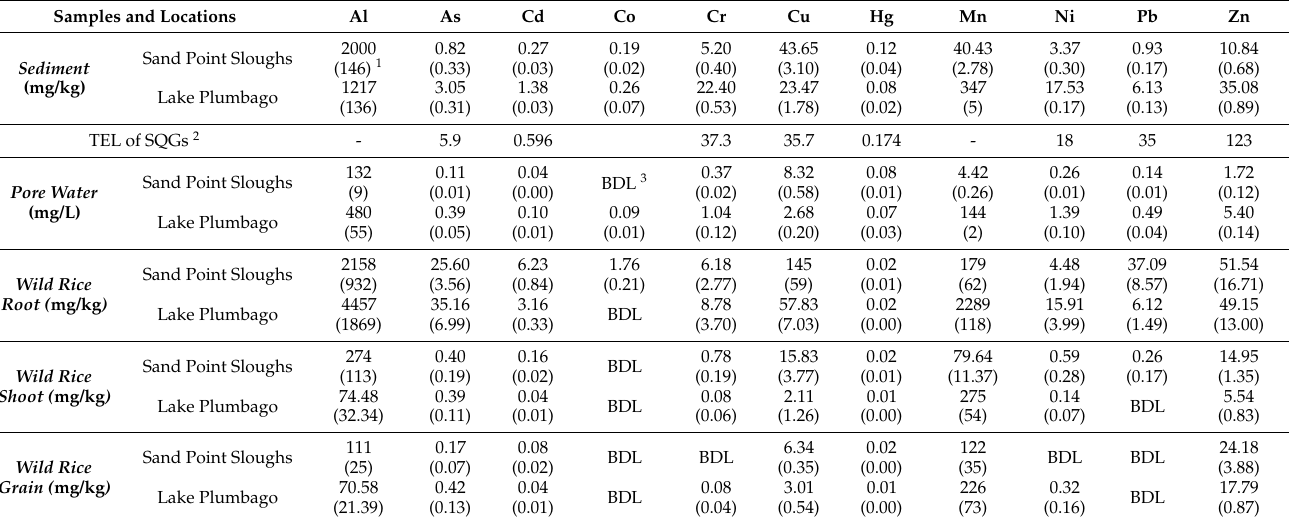
Table 1. Total toxic elements concentrations of sediment, water, porewater, and wild rice samples from Sand Point sloughs and Lake